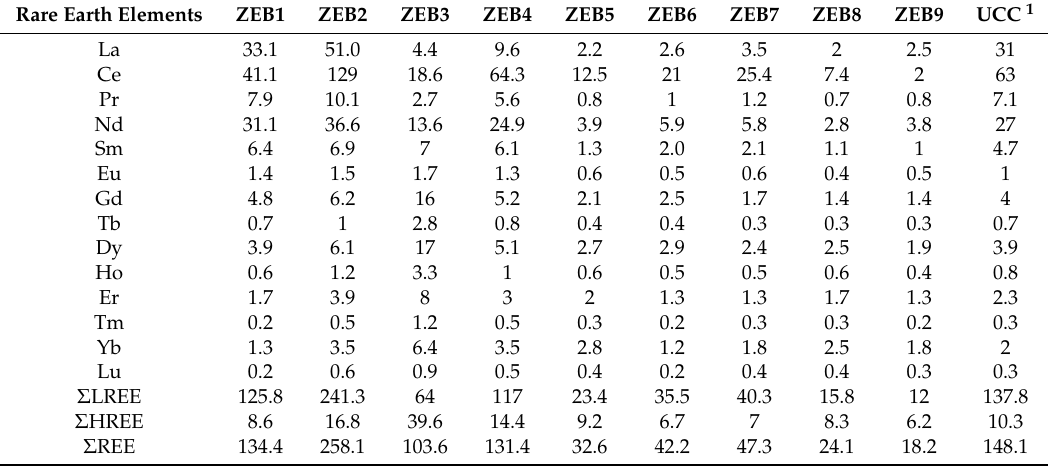
Table 6. Rare earth element composition in ppm of the clay size fraction of the Zebediela kaolin.